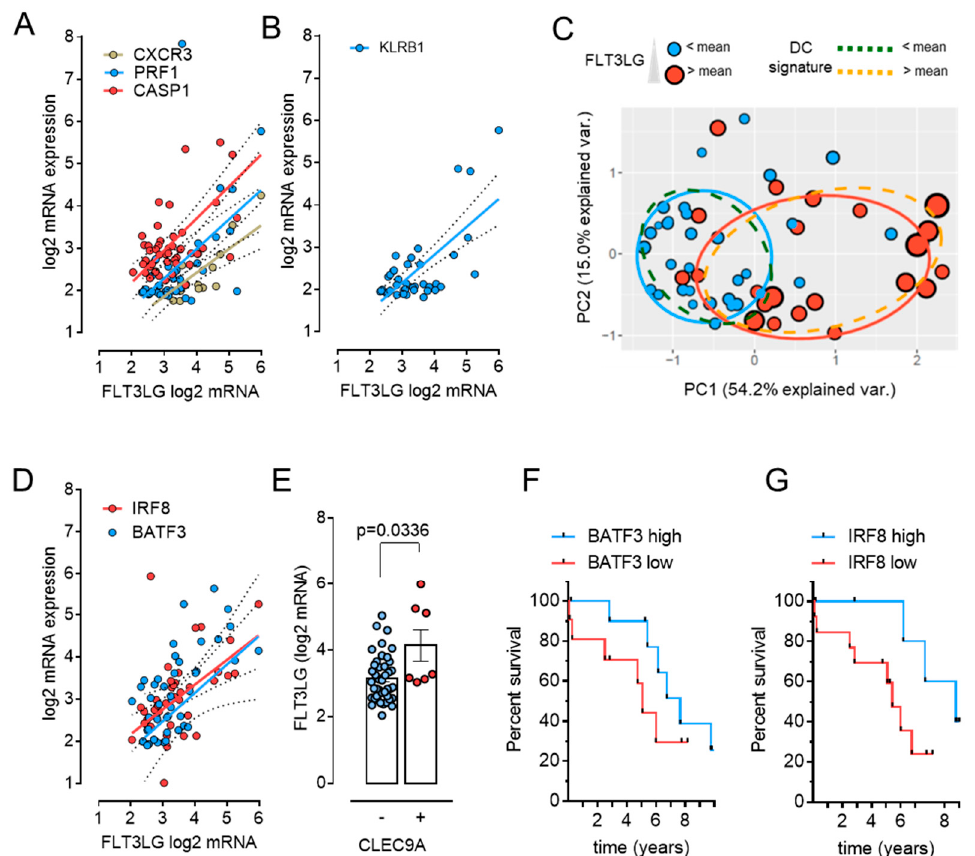
Figure 3. FLT3LG mRNA expression correlates with markers of immunogenic cell death and cDC1 maturation. Correlation of FLT3LG mRNA with mRNA expression of markers for immunogenic cell death ( A ), T- or NK cells ( B ), cDC1 cell maturation ( D , E ), and with clustering of samples according to a dendritic cell signature ( C ). Solid and dotted lines in graphs represent linear regression and error, respectively. Correlations were evaluated based on Spearman’s rank correlation coefficient. Tissues with mRNA transcript levels for a given marker at background level were excluded from the correlation analysis, resulting in different sample numbers in analyses for different markers, as is indicated for each marker below. ( A ) Positive correlation of FLT3LG mRNA with three markers of immunogenic cell death (rs = 0.33, p = 0.019 for CASP1, n = 49; rs = 0.46, p = 0.0018 for PRF1, n = 43; rs = 0.63, p = 0.0181 for CXCR3, n = 14). Inclusion of normal tissues allowed an evaluation of FLT3LG correlation with CXCR3 in additional 5 samples and corroborated a positive correlation (not shown, rs = 0.63, p = 0.004). ( B ) Correlation with KLRB1 mRNA, a marker present on NK as well as T effector cells; rs = 0.54, p = 0.0002, n = 44. ( C ) Principal component analysis of the correlation matrix of NEN transcriptomes following supervised clustering based on a gene signature for activated dendritic cells [36]. Symbol colors denote above or below average mRNA expression of FLT3LG (red and blue). Symbol size gives a more gradual indication of FLT3LG expression. Ellipses demark the region of high (dashed yellow) or low (dashed green) representation of dendritic signature genes, and of high (red) and low (blue) FLT3LG expression. Samples with above mean FLT3LG expression mostly project onto the cluster outlined by the dashed yellow ellipse, which features an above mean expression of the signature genes. Note that regions of high FLT3LG and dendritic signature gene expression are almost superimposable. ( D ) Correlation with markers of cDC1 cells IRF8 (rs = 0.55, p < 0.0001) and BATF3 mRNA (rs = 0.63, p < 0.0001), n = 49 for both. ( E ) Comparison of FLT3LG mRNA in tumor samples with ( n = 7) or without ( n = 42) detectable mRNA expression of CLEC9A, a receptor specifically expressed on cDC1 dendritic cell subsets. ( F , G ) BATF3 and IRF8 cDC1 marker mRNA and disease-related survival. Kaplan–Meier curves of DRS in patients harboring tumors with high (log2 TPM > 3.619, blue) or low (log2 TPM ≤ 3.619 red) BATF3 mRNA ( F ), or with high (log2 TPM > 3.494, blue) and low (log2 TPM ≤ 3.494, red) IRF8 mRNA ( G ). Cut-off values were determined based on ROC curves at 6 years in order to match the FLT3LG analyses. As cDC1 are perceived as the main Flt3L-responsive cells in the tumor microenviron- ment, we used the activated dendritic cell gene signature from the well-established